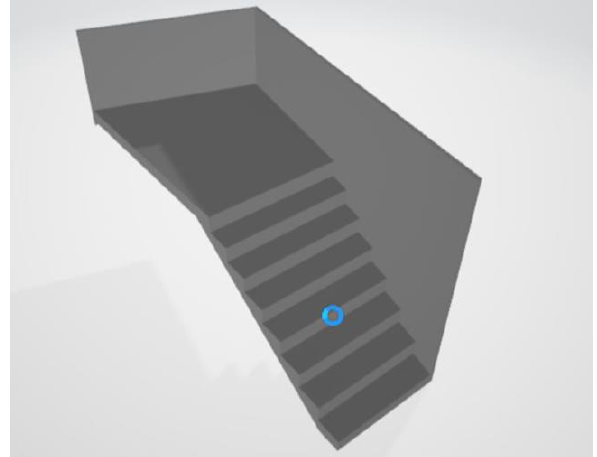
Figure 11. The model performed for the construction of the COR-TEN staircase.